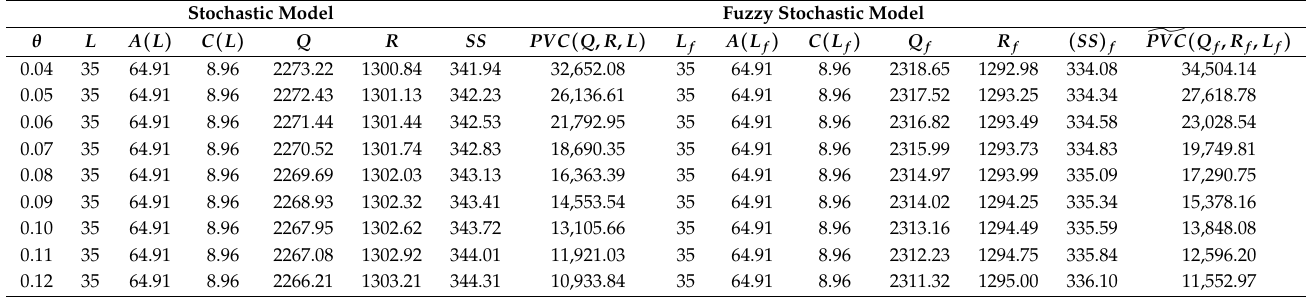
Table 10. Effect of the time value of money in the stochastic and fuzzy stochastic